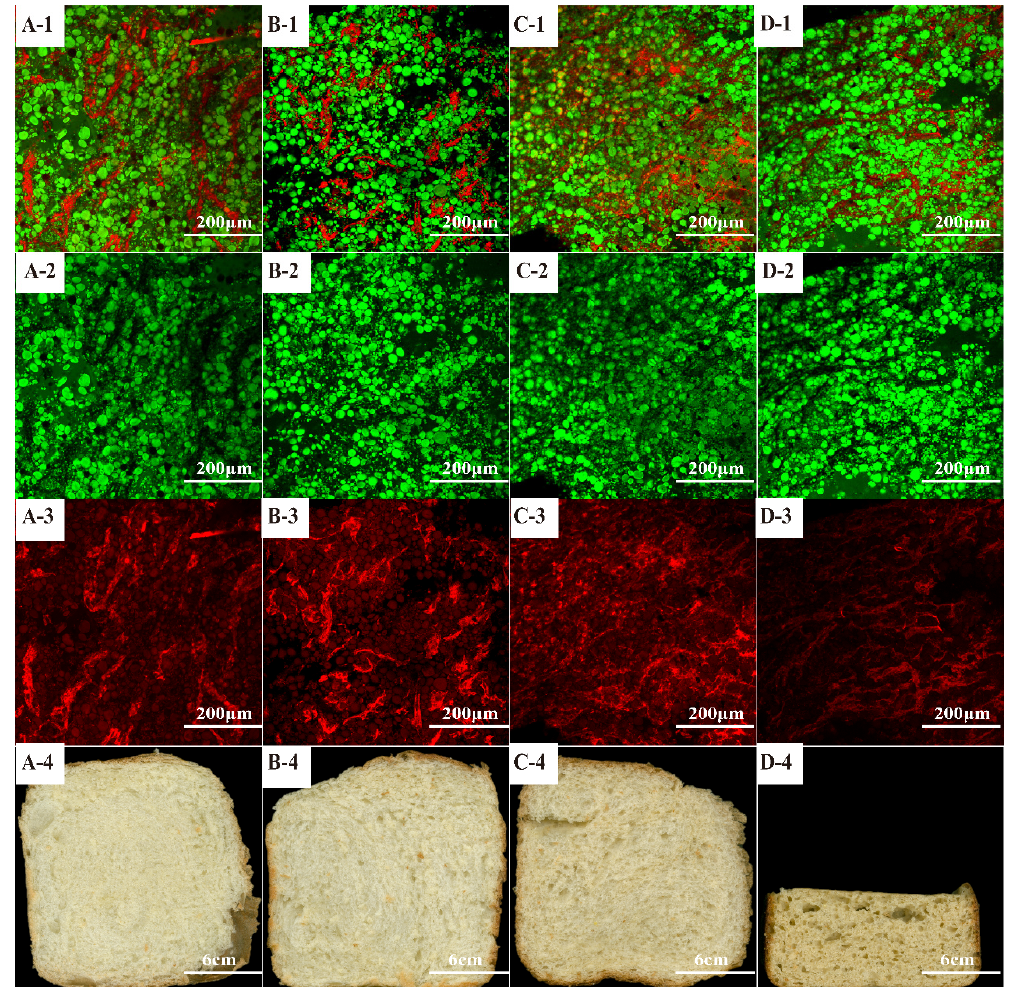
Figure 1. CLSM micrographs of dough matrix and bread pictures. ( A1 − A4 ): PGR0; ( B1 − B4 ): PGR3; ( C1 − C4 ): PGR6; ( D1 − D4 ): PGR9. ( A – C , D − 1 – D − 3 ): CLSM micrographs; ( A – C , D − 4 ): Pictures of bread slices.